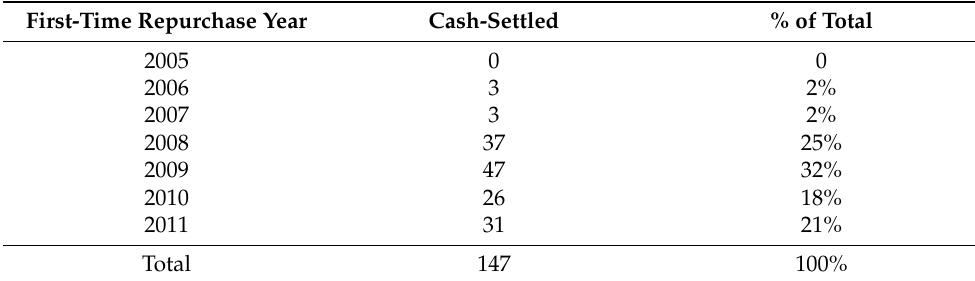
Table 4. First repurchases by